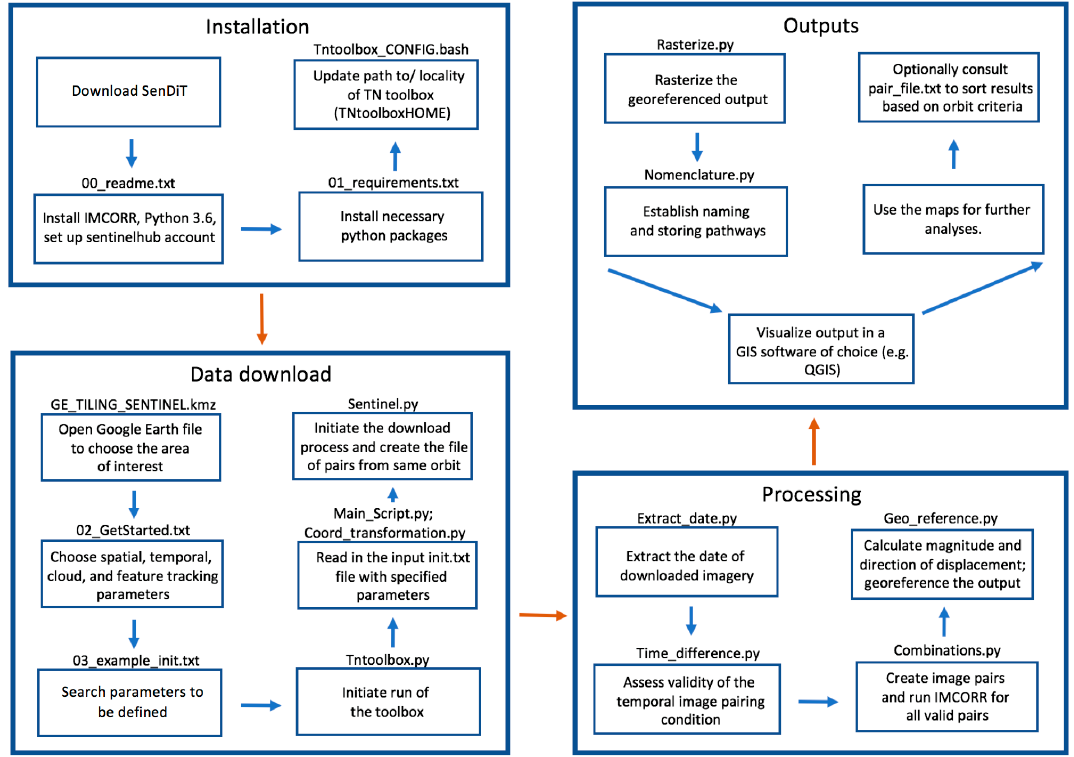
Figure 2. Schematic diagram of SenDiT processing chain.